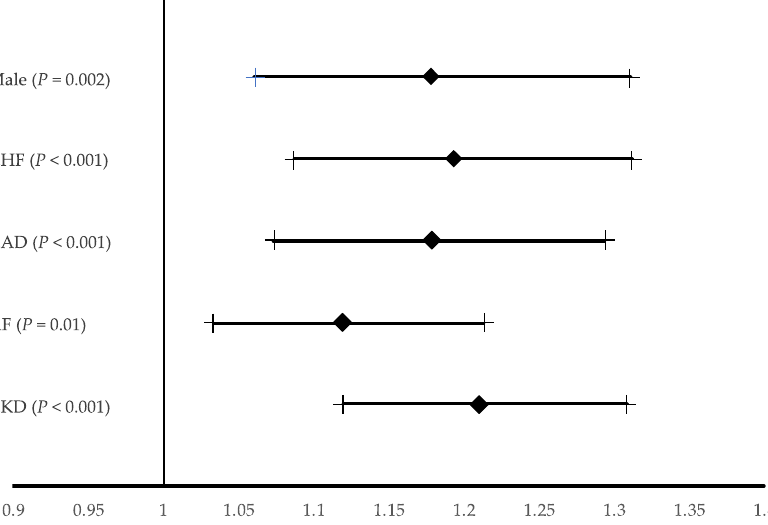
Figure 3. Multivariable backward stepwise selection logistic regression model. Odds ratio for post-contrast acute kidney injury. The data are presented as odds ratios with 95% confidence intervals (Hosmer-Lemeshow Statistic 0.599). AF, atrial fibrillation; CAD; Coronary artery disease; CHF, Chronic Heart Failure; CKD, chronic kidney disease.